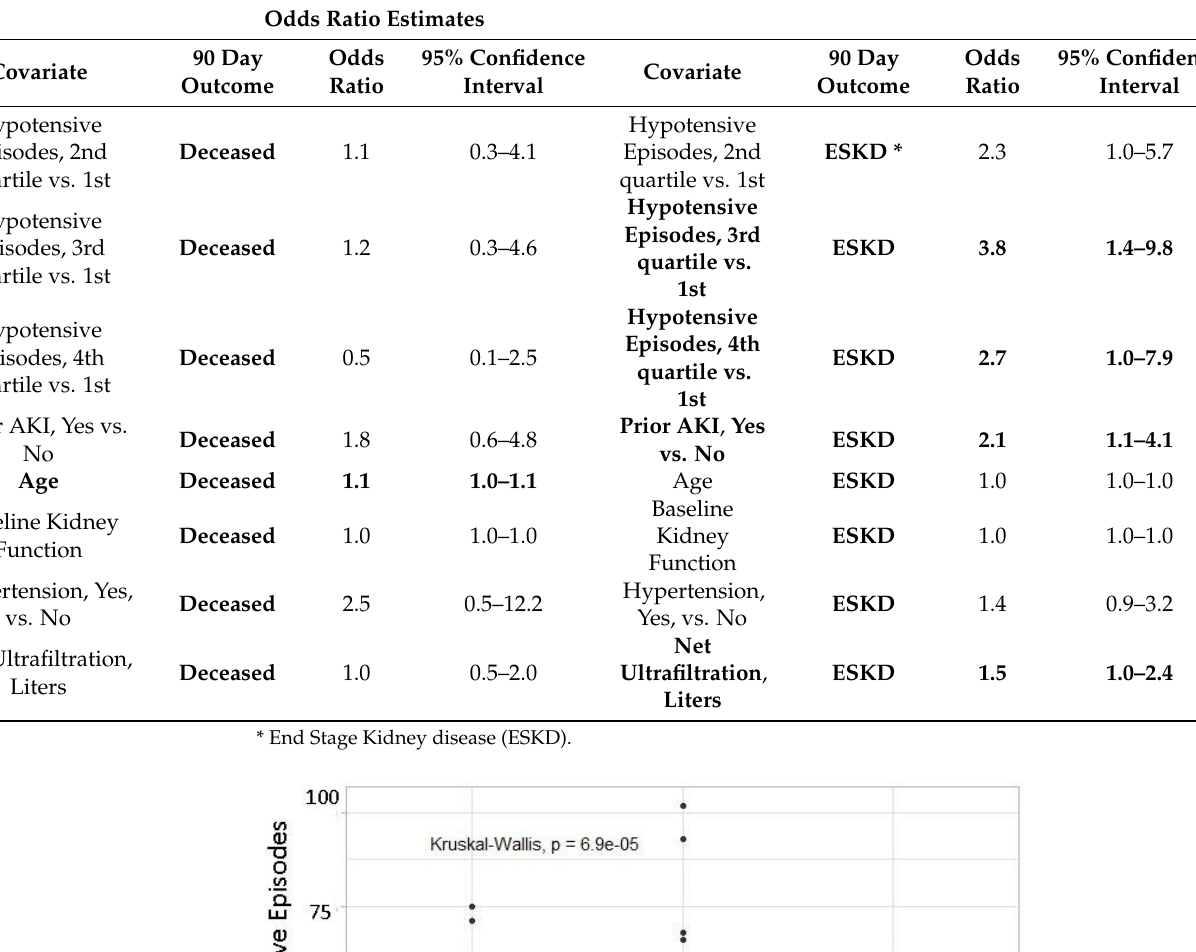
Table 2. Multinomial Logistic Regression Model Results.